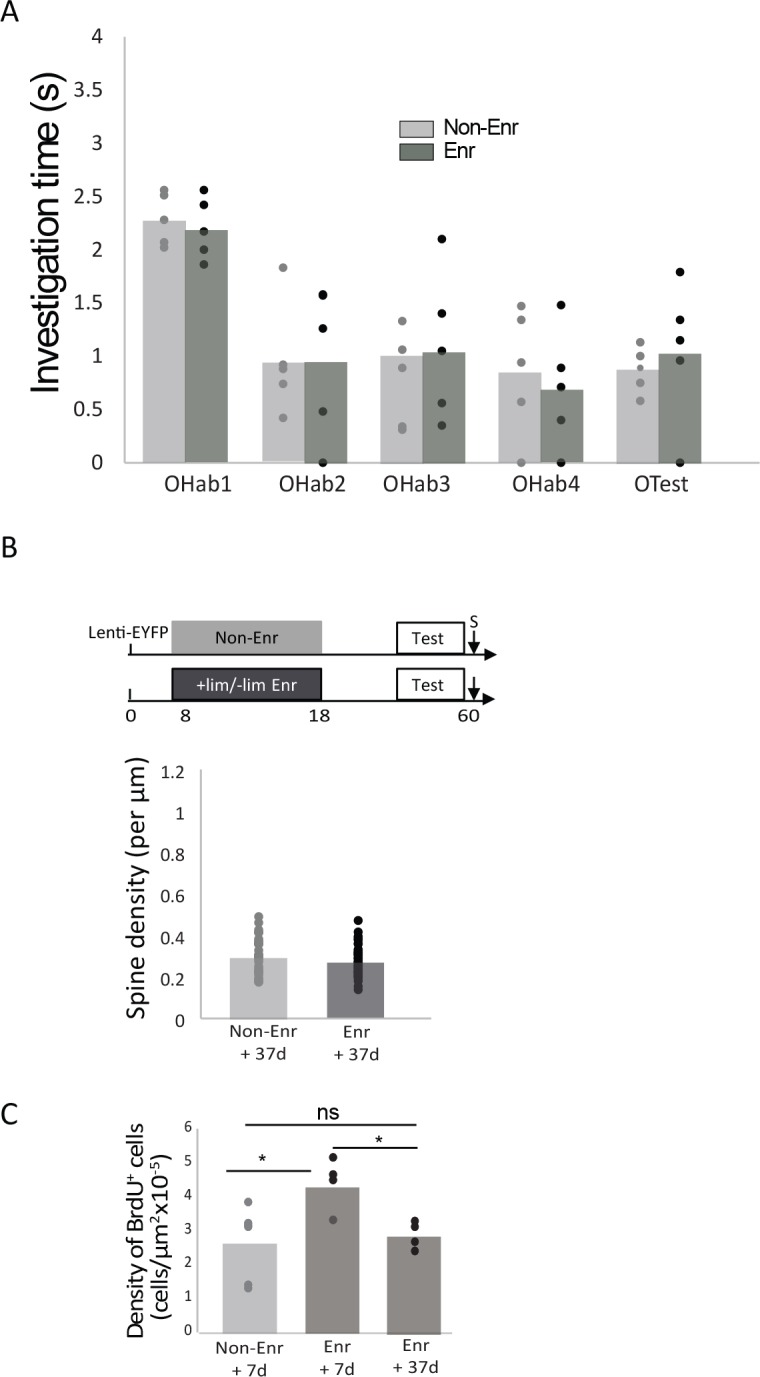
Long-term delay after implicit learning.(A) 42 days after implicit learning, the habituation/cross habituation task indicated that there was still no discrimination between +lim and –lim in the non-enriched control group (Non-Enr) and that the enriched (Enr) group could not longer discriminate them. Indeed, investigation time remained similar between OTest and OHab4 in the non-enriched (Wilcoxon p=0.8, n = 5) and the enriched group (Wilcoxon p=0.34). Both groups habituated correctly (Friedman test, Non-Enr (n = 5, p=0.02; Enr (n = 5, p=0.01). (B) 42 days after implicit learning, no difference in spine density in the apical domain was observed between Non-Enriched (Non-Enr) and Enriched (Enr) animals (Mann-Whitney p=0.23; Enr: 48 dendritic segments n = 4 mice and Non-Enr: 38 dendritic segments n = 4 mice). (C) 37 days after implicit learning, the density of BrdU-positive cells has returned to control non-enriched level (Enr +37 d: n = 5; Anova group effect: F(2,12)=6 p=0.015; 7 days versus 37 days post enrichment, Bonferroni test p=0.04). The data are expressed as mean values ± SEM.